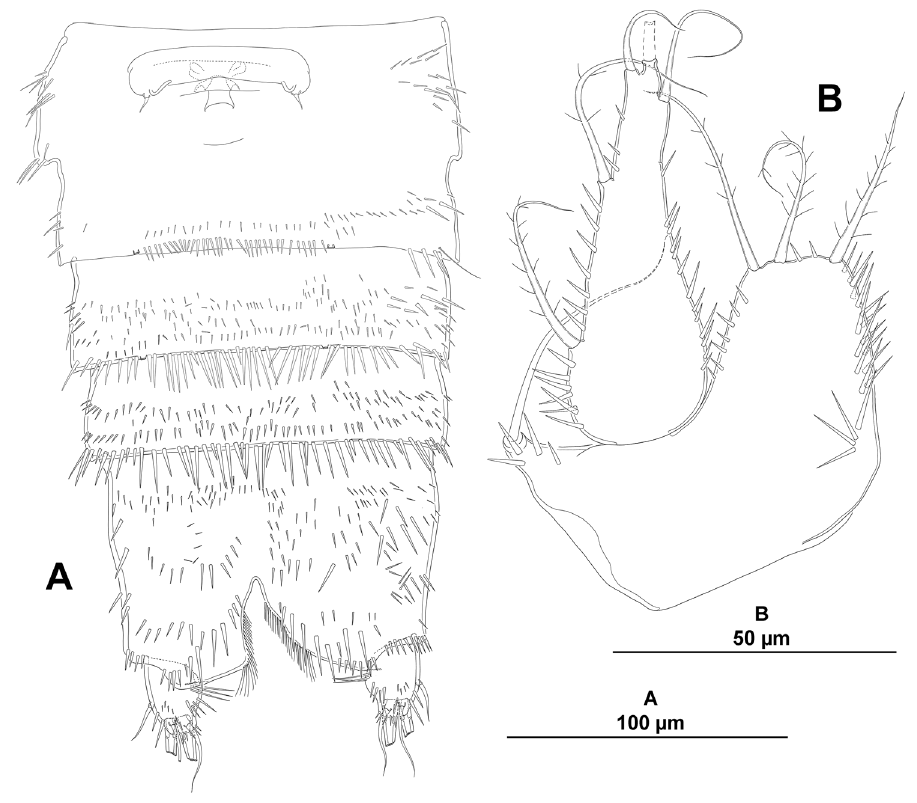
Figure 10. Odiliacletodes secundus sp. n., female holotype. A urosome, ventral (P5-bearing somite omitted) B P5,